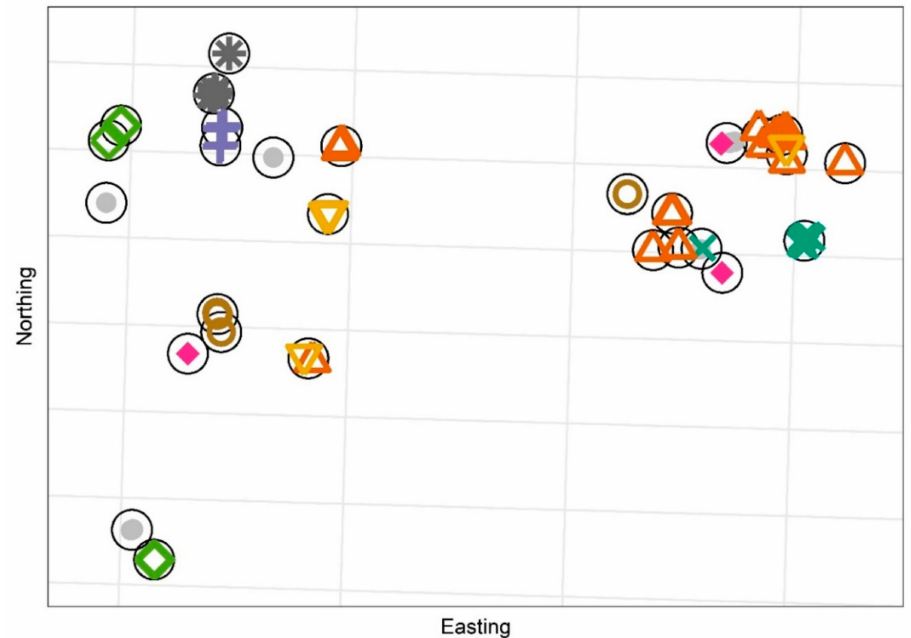
Figure 1. Clustering of spatial coordinates to identify distinct dwellings (n = 28). Each symbol represents a survey response. Participants with one or two responses are depicted as grey circles, all other participants (n = 8) are depicted using a unique